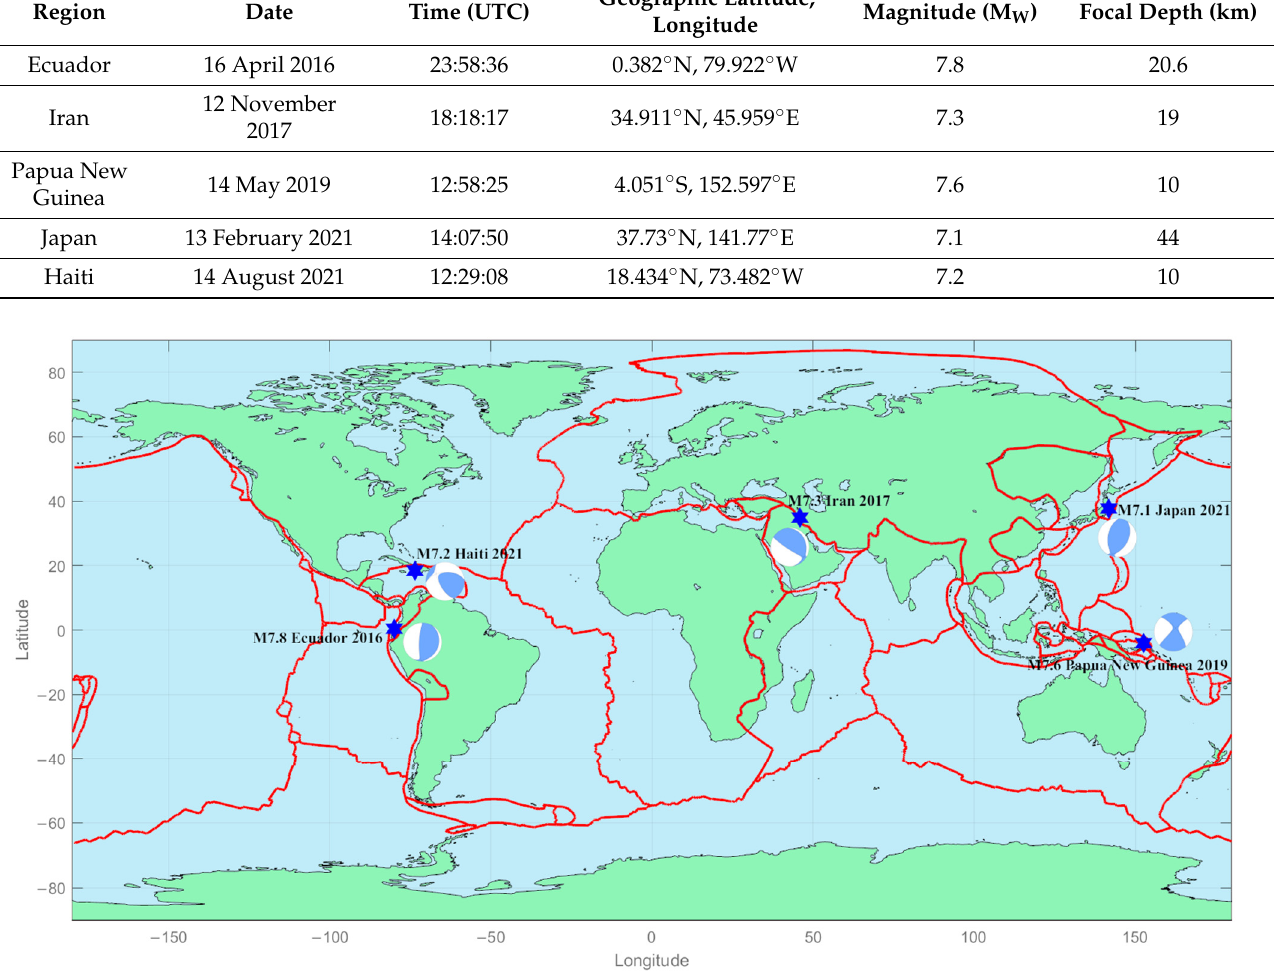
Table 1. The characteristics of the investigated earthquakes (reported by United States Geological Survey, http://earthquake.usgs.gov/ (accessed on 5 June 2022)).